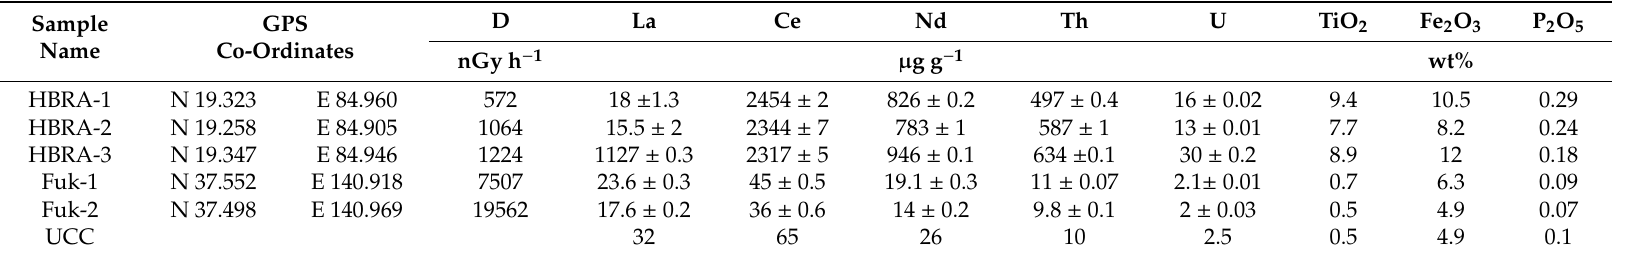
Table 2. Elemental concentration of high background radiation area (HBRA) and Fukushima